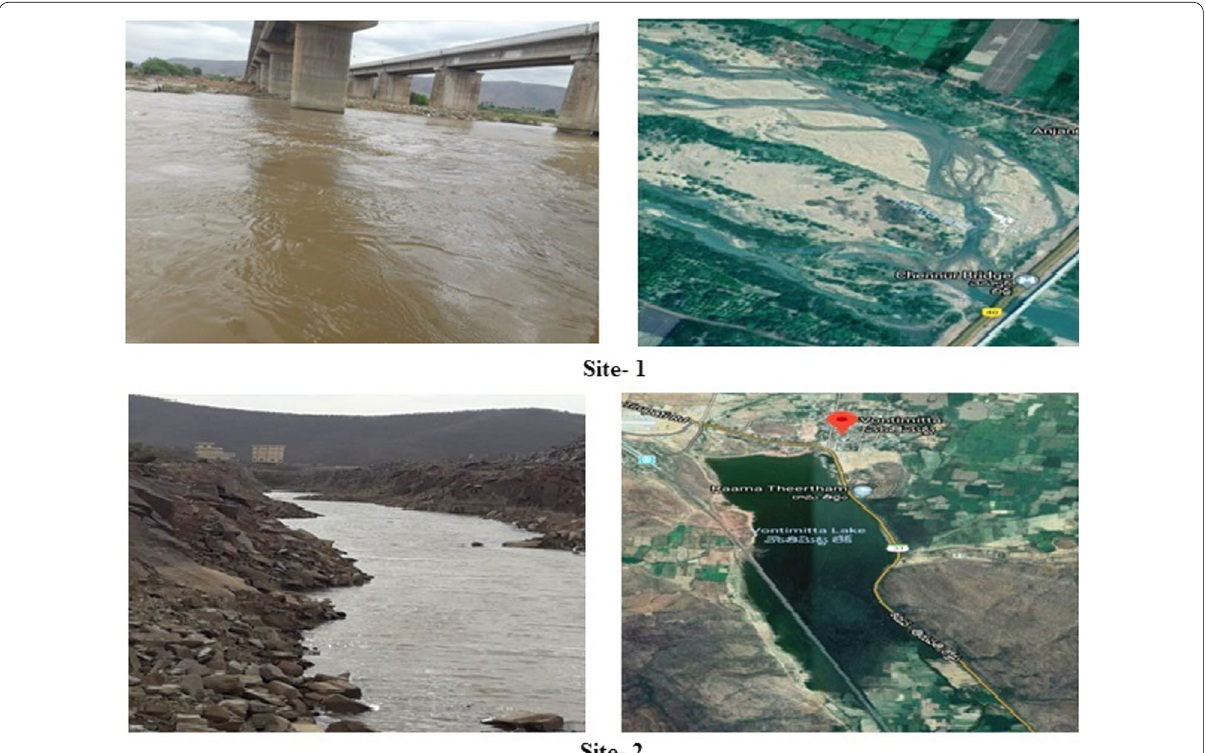
Fig. 1 Geographical location of the two fish sampling sites of YSR Kadapa District, Andhra Pradesh. Site-1: Adinimmayapalli Dam across the Penna River in Chennur Village, YSR Kadapa District. Site-2: Backwaters of Somasila reservoir across the river Penna in Somasila Village, Nellore